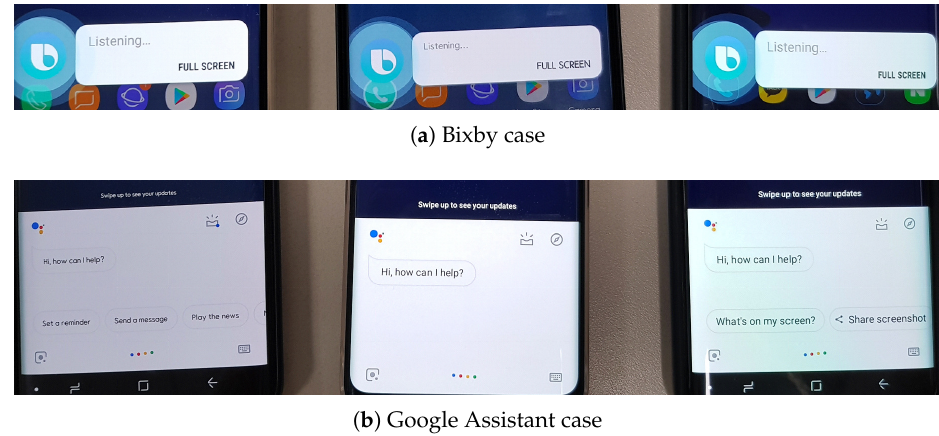
Figure 1. Uncoordinated react of voice-based